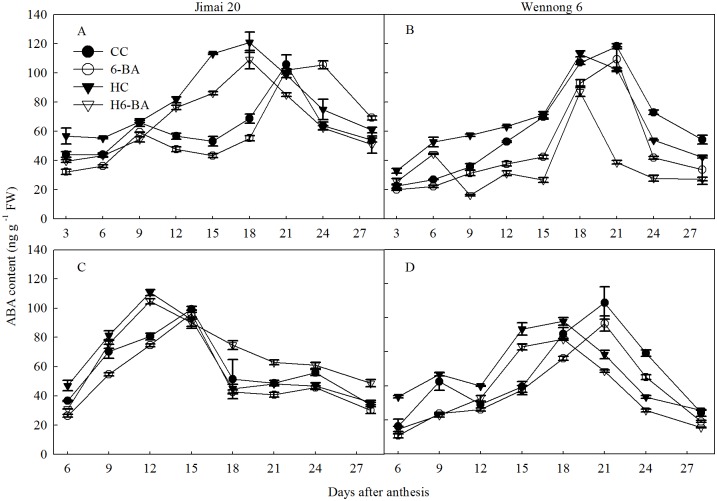
ABA content in superior (A, B) and inferior kernels (C, D).CC and 6-BA represent treatment with water and 6-BA under non-heated condition, respectively. HC and H6-BA represent treatment with water and 6-BA under heated condition, respectively. Vertical bars represent ± standard error of the mean (n = 3) where they exceed the size of the symbol.